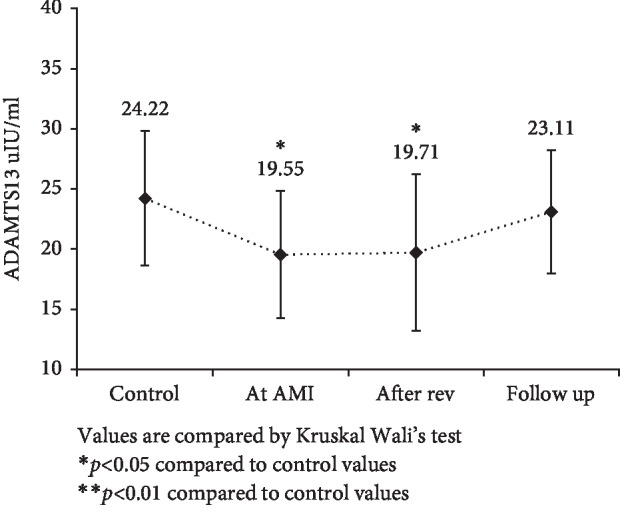
Comparison of ADAMTS13 levels in control, at AMI, after revascularization and at 4–6 weeks of follow-up in AMI patients with control subjects. Values are compared by Kruskal Wallis test. ∗p < 0.05 compared to control values. ∗∗p < 0.01 compared to control values.